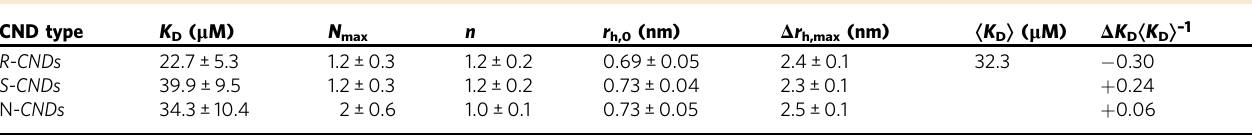
Fig. 3. Here the time-dependence of the uptake is shown. The corresponding concentration - dependence is presented in the “ Methods ” section. The data show that consistently there is (at the same incubation concentration C ′ CND ) lowest internalization of N- CNDs, and highest internalization for S- CNDs, as well for HeLa cells as for THP-1 derived macrophages (Fig. 3a versus Fig. 3b), quanti fi ed by both fl ow cytometry and confocal microscopy (Fig. 3b versus Fig. 3d). The question is now whether these differences in - between the different types of CNDs are signi fi cant. For this, the values at t = 48 h are analyzed in Table 3.